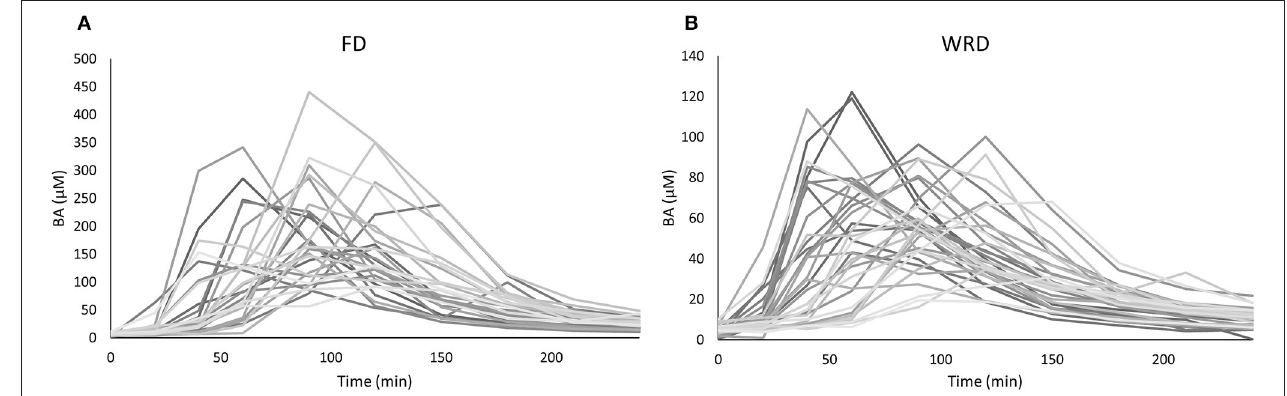
FIGURE 1 | Variability in plasma pharmacokinetics in an anthropometric diverse sample following a (A) fixed (FD) and (B) weight-relative dose (WRD). Plasma β -alanine (BA) concentrations ( µ M) were determined before and at nine time points after the ingestion of 1,400mg (A) or 10 mg/kg BW (B) BA. The observed variation in iAUC is 35.0 and 33.2%, respectively.